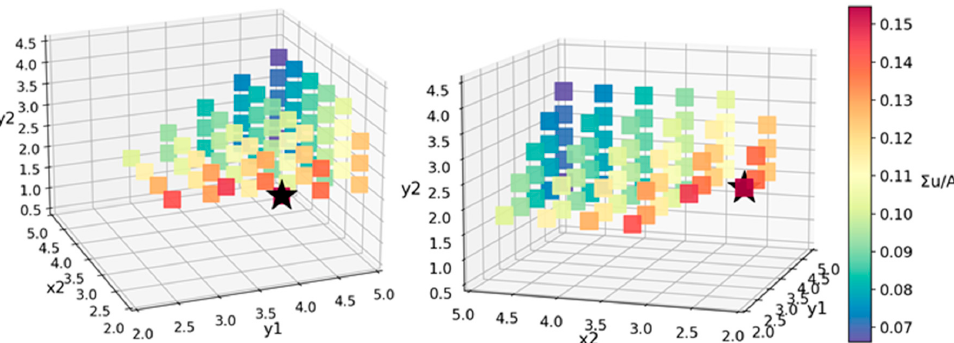
Figure 14. The three-dimensional scatter diagram of array power density (truncation ratio is 0.6). The missing scatters represent that the inflow velocity under this distance parameters is less than the truncation ratio. The left and right pictures are two different side views of the scatter. The three axes are the three distance parameters ( y 1, x 2, y 2). The color bar represents the array power density. The black star represents the maximum array power density (Its coordinates are y 1 = 3.5, x 2 = 2, y 2 = 2).